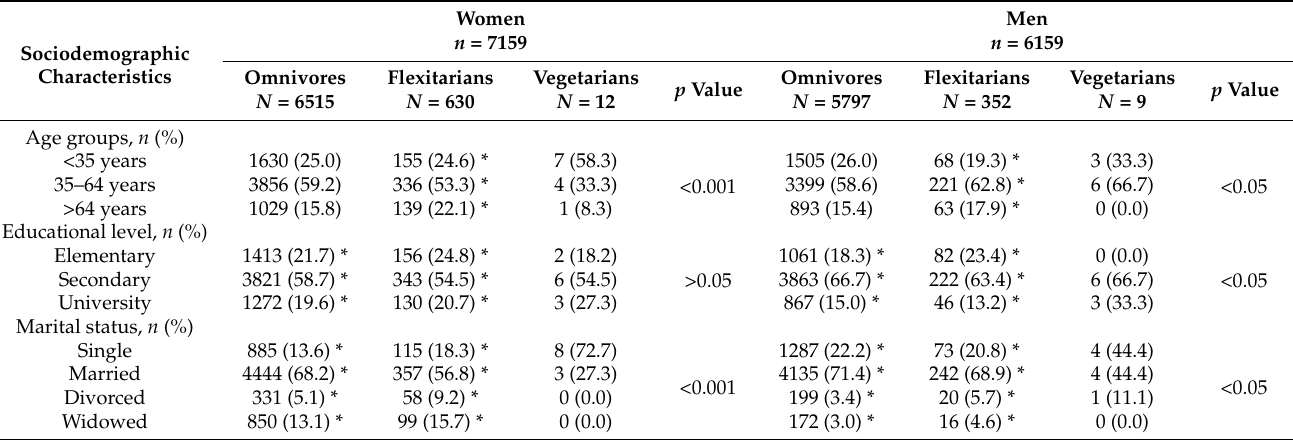
Table 1. Sociodemographic characteristics of the studied sample according to the dietary pattern, by gender (National Multicenter Health Survey WOBASZ and WOBASZ II, n = 13